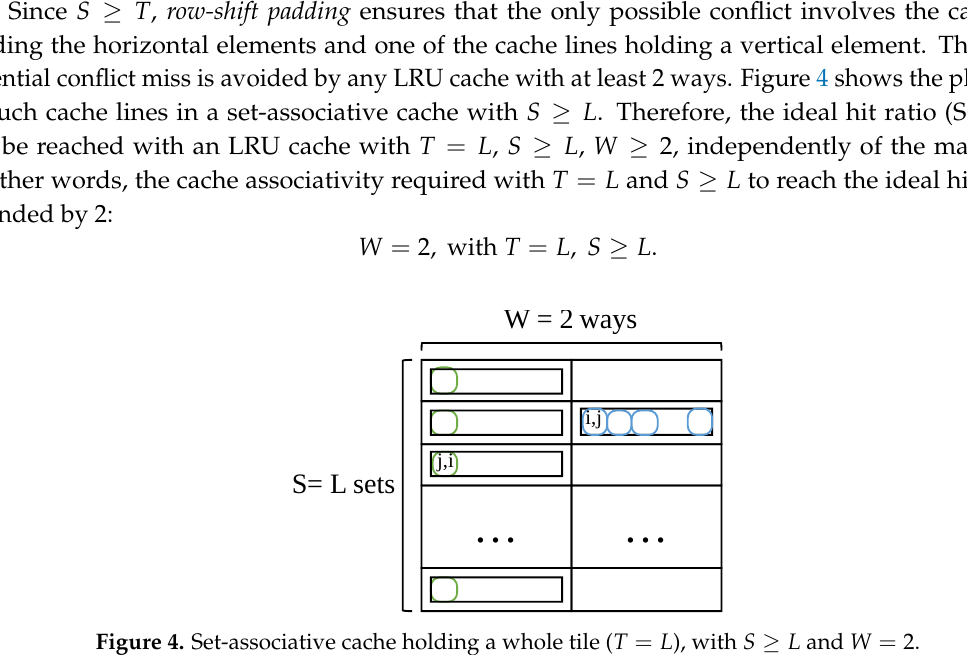
N matrix assuming T = L . ×